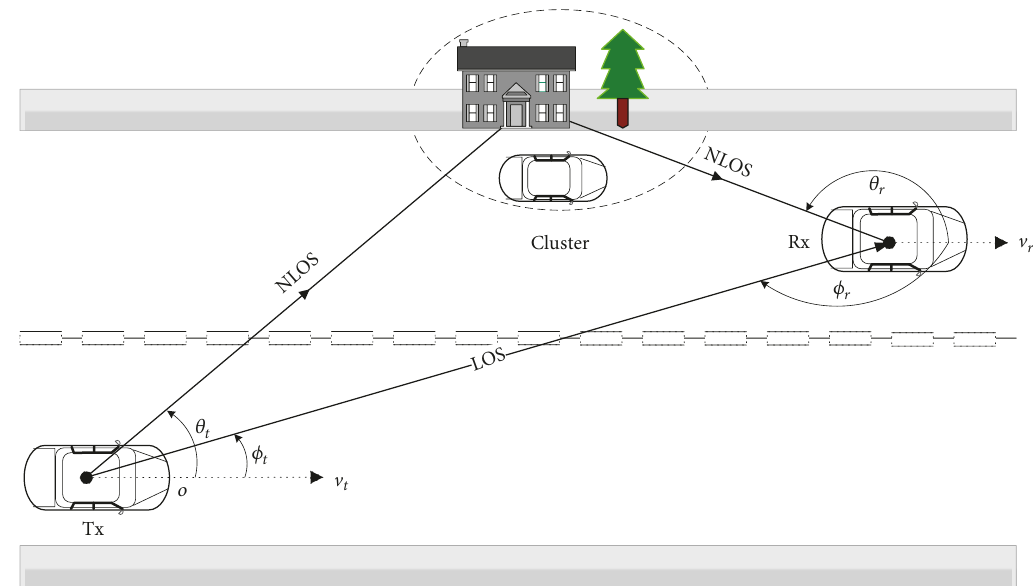
Figure 1: Simplified overview of SCM V2V scattering channel model.